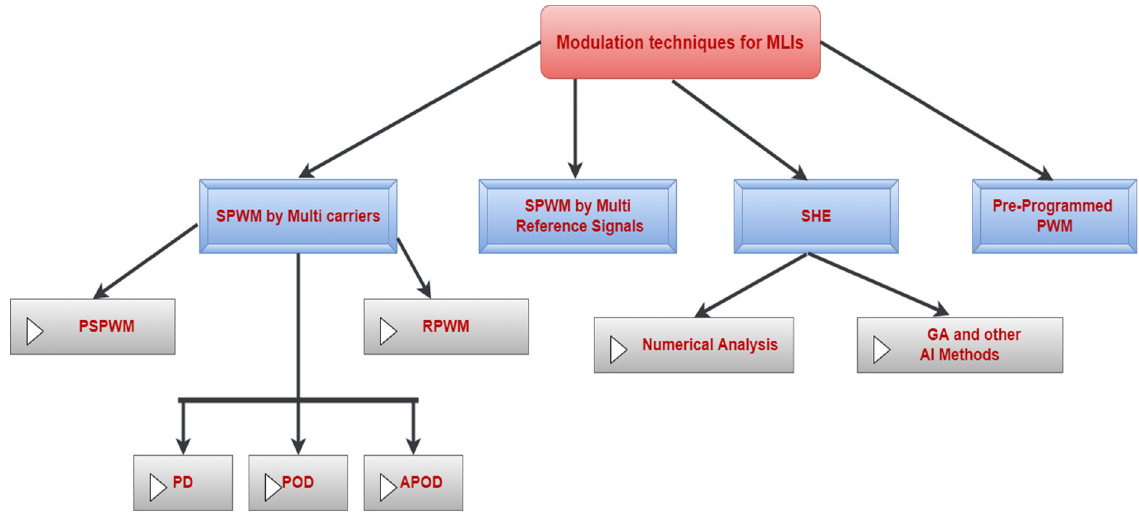
Figure 14. Modulation techniques of single-phase MLIs.